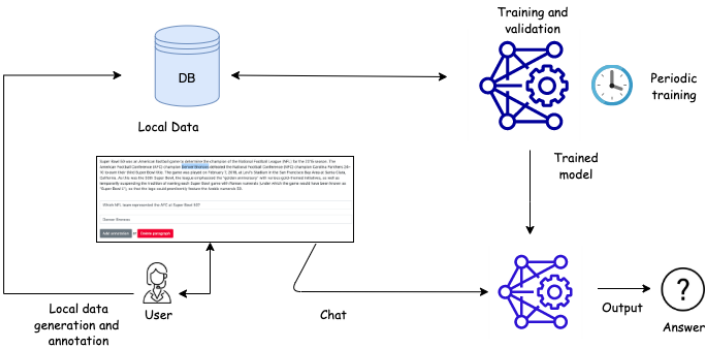
Figure 4. Federated incremental learning process. Clients can add data continuously to extend the existing model’s knowledge locally while training a global model, the generated data can be stored locally on the